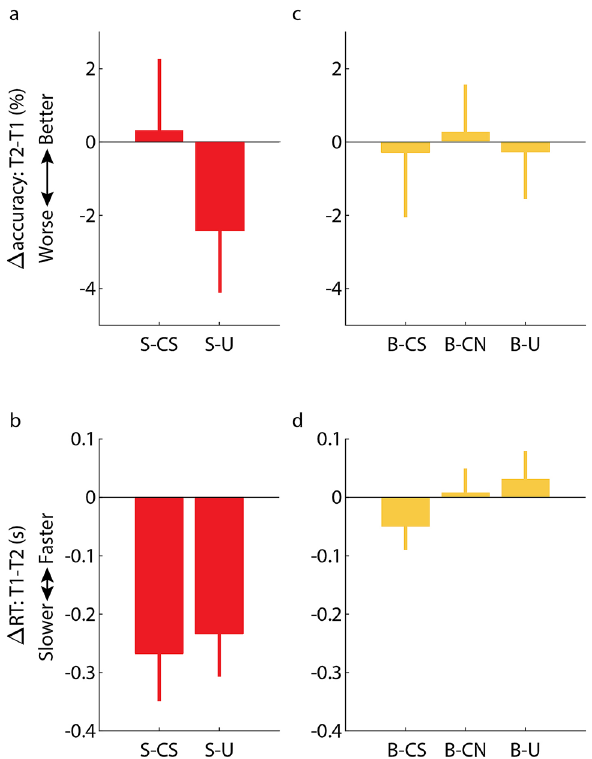
Figure 3. Reactivation during sleep did not have a suppressive effect. ( a ) Change in accuracy from T1 to T2 was similar for no-think pairs that were cued during sleep (S-CS; suppression–cued suppression) and those that were not (S-U; suppression–uncued). ( b ) A parallel analysis showed no differences in RT between the two conditions. ( c ) Change in accuracy was also similar when compared among the three baseline conditions, corresponding to pairs cued with the no-think sound (B-CS; baseline–cued suppression), pairs cued with a novel sound (B-CN; baseline–cued novel), and pairs that were uncued (B-U; baseline–uncued). ( d ) A parallel analysis was conducted for the change in RT. Values reflect coefficient estimates produced by the linear model; error bars denote standard error of the mean for